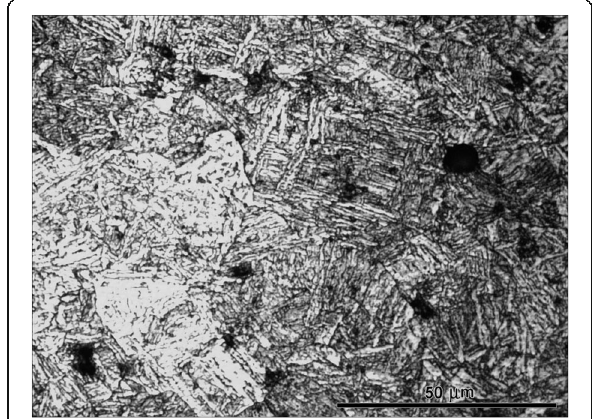
Fig. 5 Optical micrograph of ASTM 514 grade S